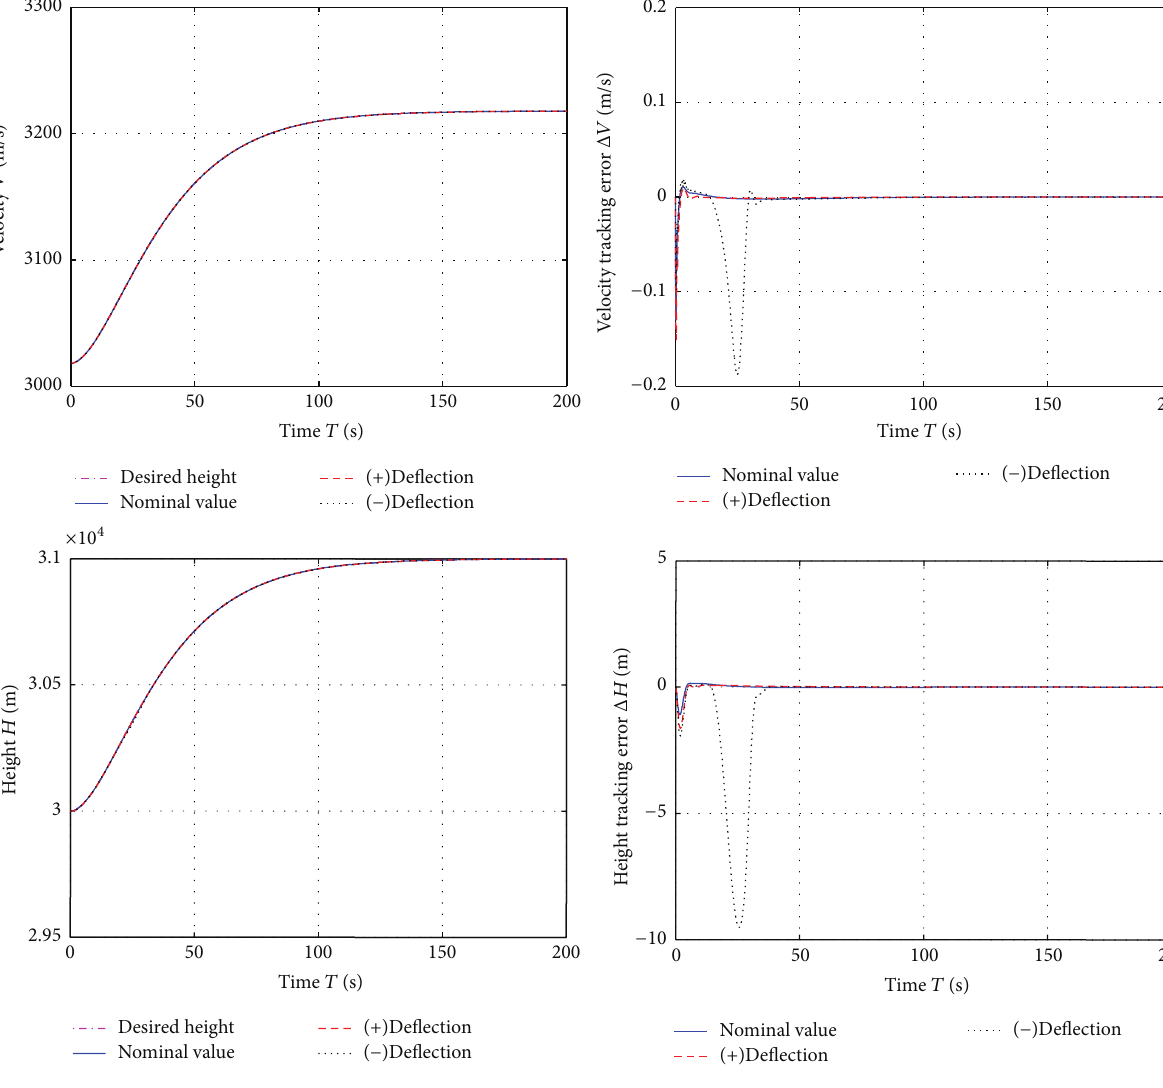
Figure 2: Response to tracking commands and tracking error